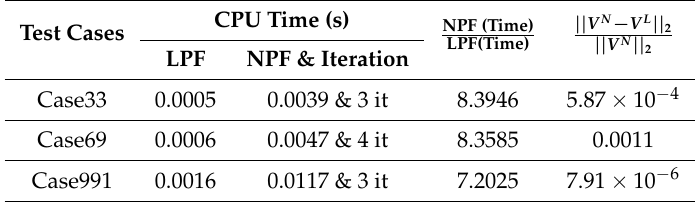
Table 1. The CPU time of non-linear power flow (NPF) and linear power flow (LPF) computations (Average of 10 computations) and relative difference.